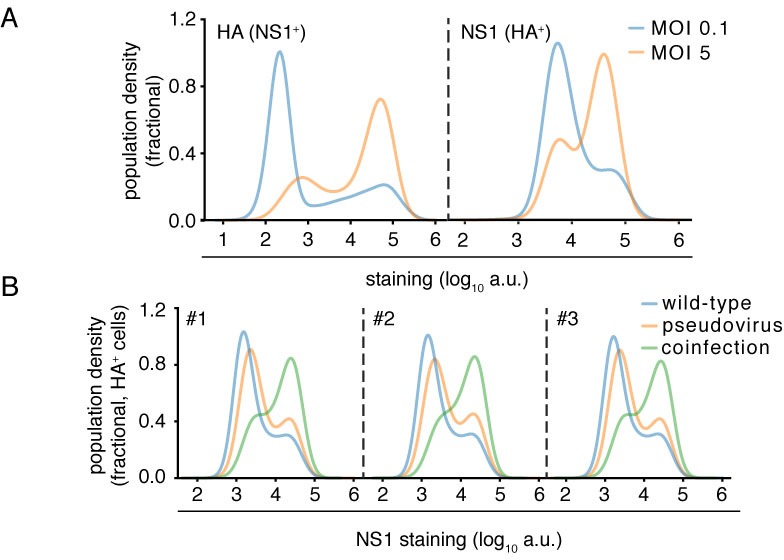
Effects of infectious dose or coinfection state.(A) Flow cytometry analysis of expression of viral proteins in cells infected at high (MOI five as calculated by TCID50 on MDCK-SIAT1 cells) or low (MOI 0.1) initial infectious dose. Cells were concurrently stained for HA and NS1 proteins at 10 hr after initiation of infection, and then analyzed by flow cytometry. The level of HA protein was quantified in cells that were identified as infected based on being positive for NS1 protein (left), and the level of NS1 protein was quantified in cells that were identified as infected based on being positive for HA protein (right) While a higher dose leads to more cells expressing high amounts of viral protein, it does not greatly increase the amount of viral protein in either the low-expressing or high-expressing cells. Therefore, higher viral dose does not lead to a large continuous increase in viral protein production among all cells – rather, it mostly changes the proportions of cells that fall in different parts of the highly heterogeneous distribution. (B) Cells were co-infected with a mix of wild-type virus and pseudovirus in which the HA gene was replaced by GFP flanked by the terminal regions of the HA gene segment at an MOI of 0.1 for each virus. At 10 hr post-infection, cells were stained for NS1 and HA expression and analyzed by flow cytometry for these proteins and GFP. Cells could be annotated as infected by virions of the same type (wild-type infection indicated by presence of HA, or pseudovirus infection indicated by the presence of GFP) or both types of virions (indicated by presence of HA and GFP). Coinfected cells, like cells infected at a higher infectious dose, occupy different positions in the distribution of viral protein production but do not not exhibit a continuous increase in viral protein production. Data are shown for three independent replicates.